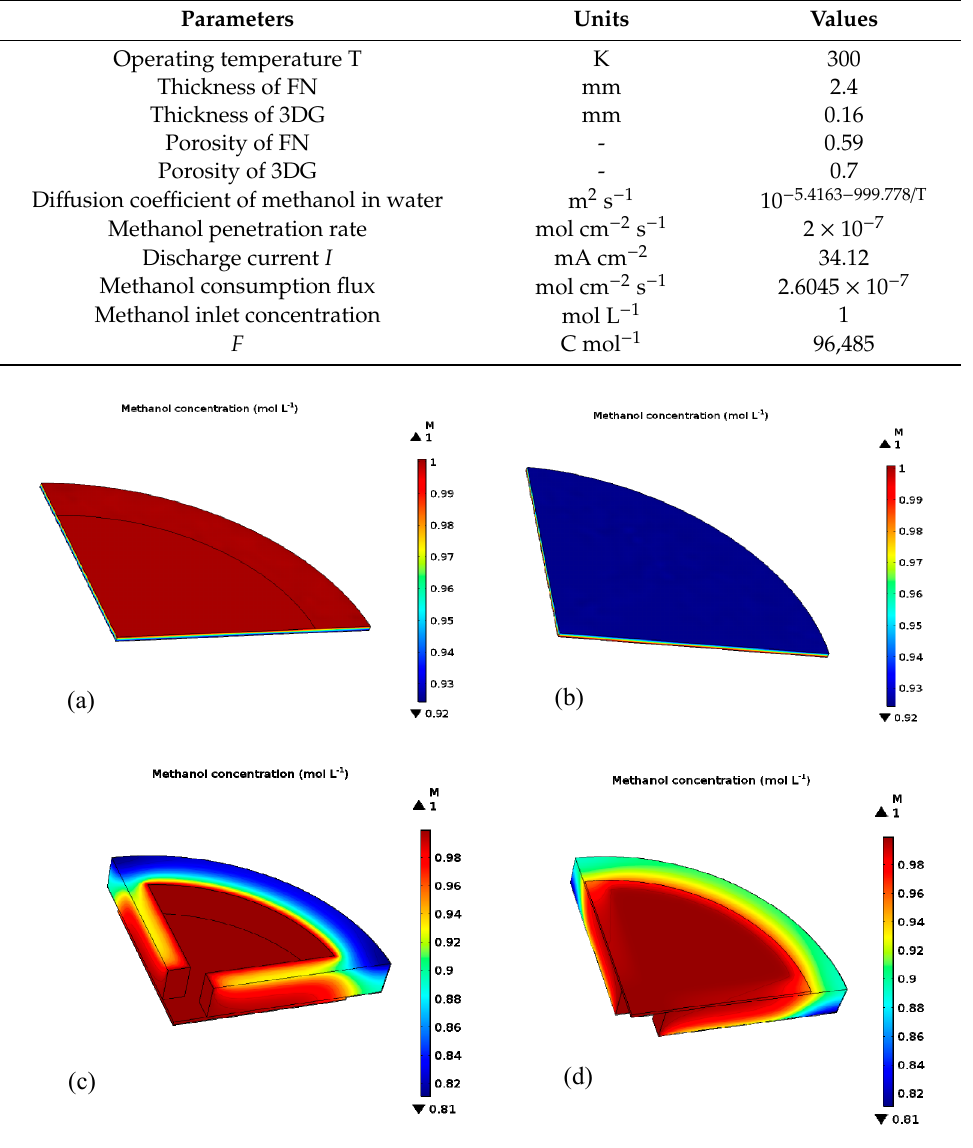
Figure 9. ( a ) The methanol concentration diffusion model of the 3DG + S cell; ( b ) three-dimensional methanol concentration diffusion model of the FN + 3DG cell.